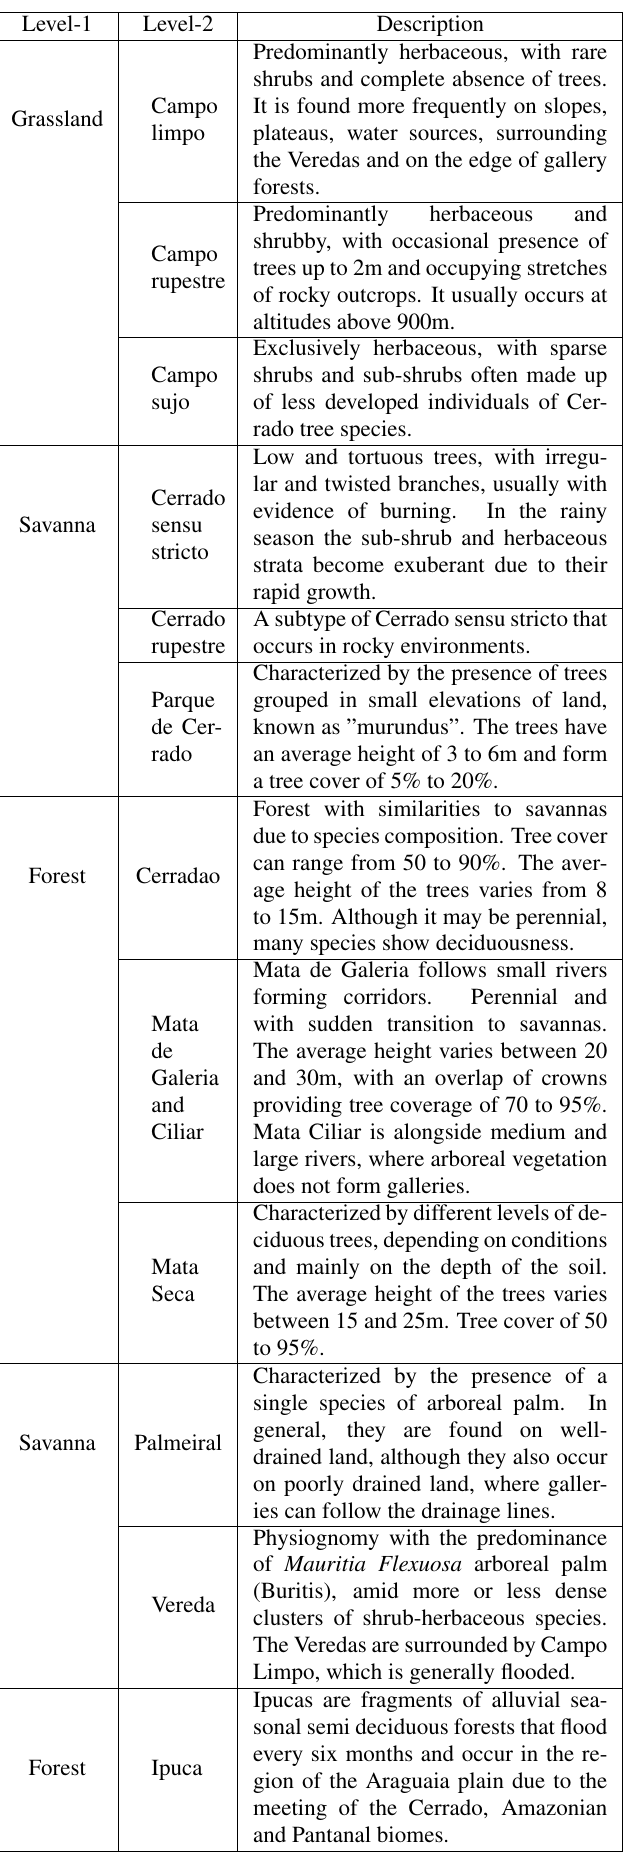
Table 1. Description of physiognomies on the 1st and 2nd hierarchical level of Ribeiro and Walter (2008)